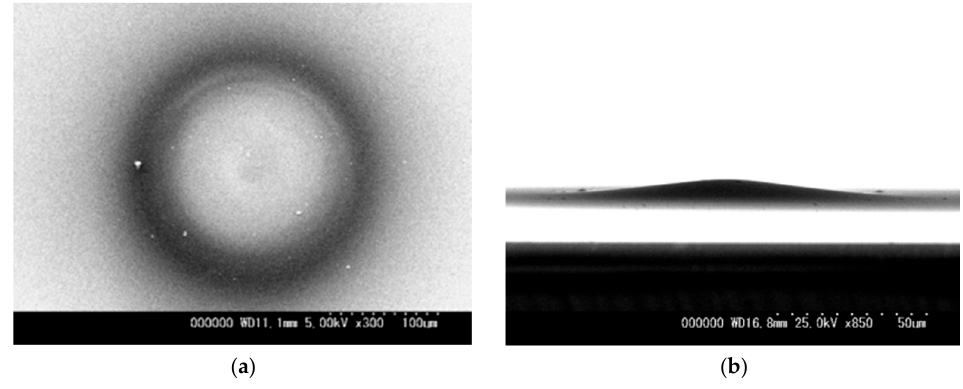
Figure 9. An optical microscope image for the film on Si wafer shown in Figure 8.